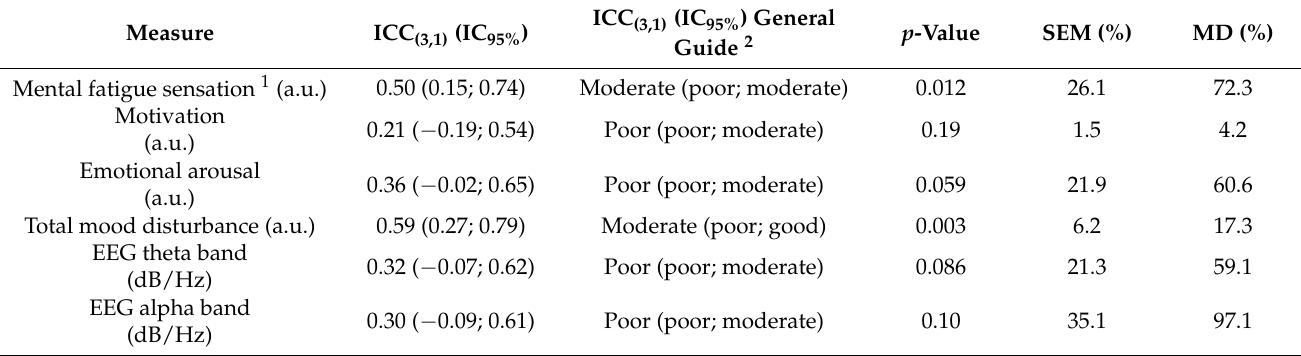
Table 2. Relative and absolute reliability analysis of psychological and physiological variables frequently used to assess mental fatigue.